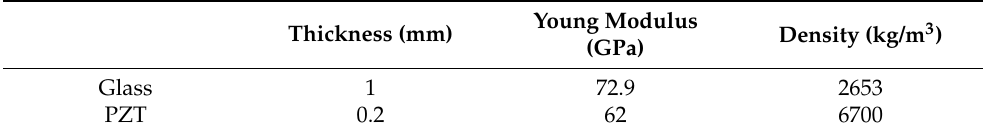
Table 1. Structural properties of the